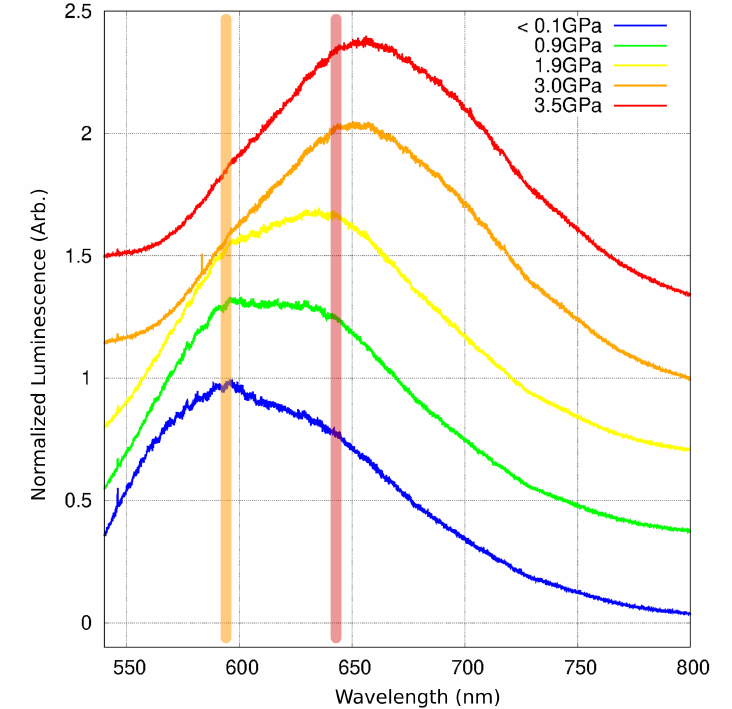
Figure 9. Luminescence spectra of 1a at selected pressures. Excitation wavelength: 532 nm. The spectra are normalized and offset along the y-axis for clarity. The orange and red bars indicate the emission maxima assigned to the initial small excimers (possibly dimers) and higher multimers